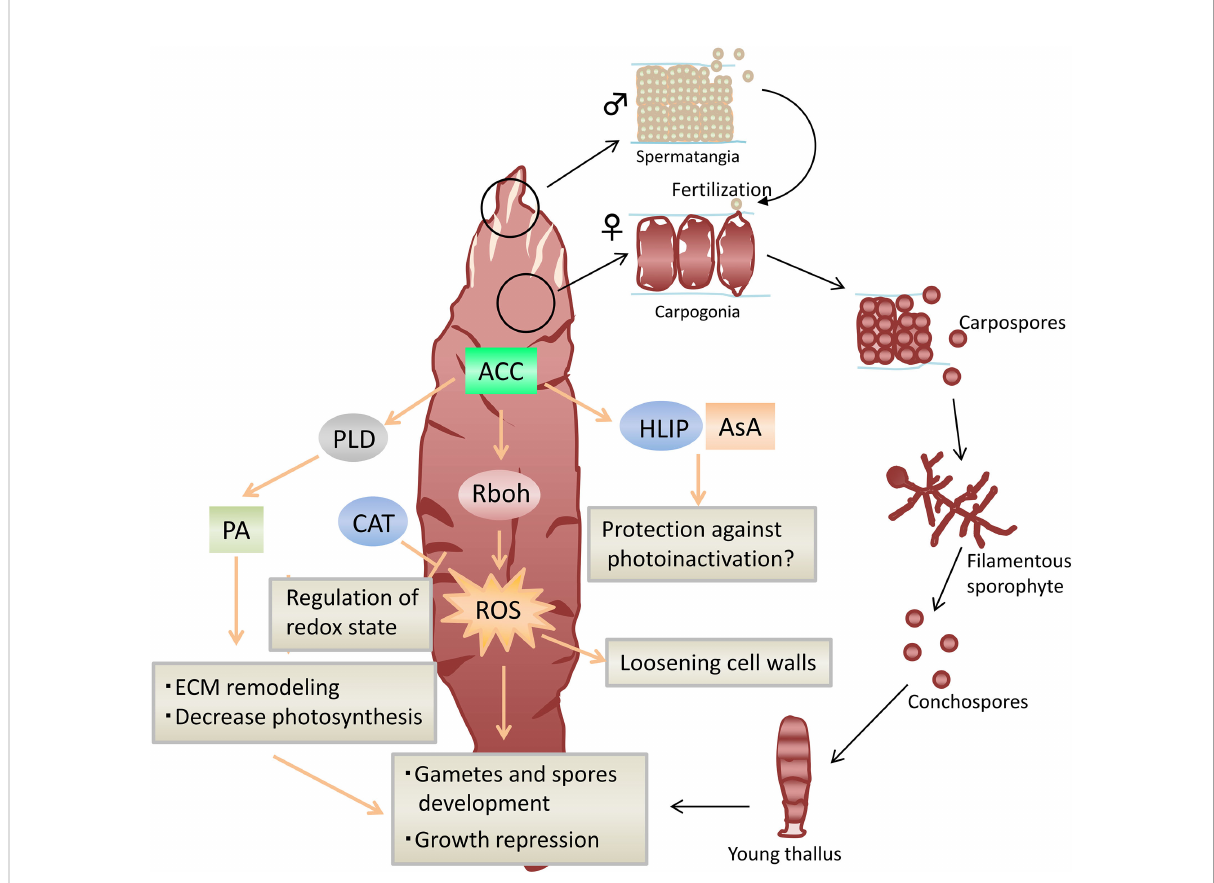
FIGURE 2 Model of ACC-mediated stress tolerance and sexual reproduction in Neopyropia yezoensis. Arrows represent positive regulation, and blocked arrows represent negative regulation. ACC, 1-aminocylopropane-1-carboxylic acid; ROS, reactive oxygen species; CAT, catalase; PLD, phospholipase D; PA, phosphatidic acid; Rboh, respiratory burst oxidase homolog; HLIP, high-light-inducible protein; AsA,